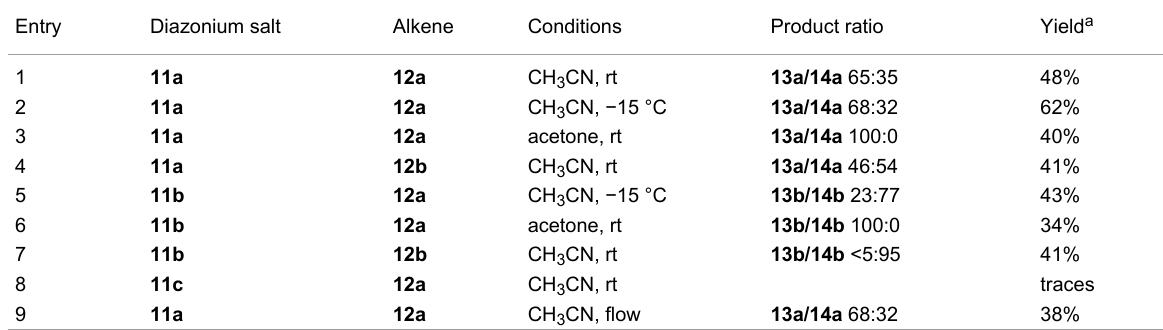
Table 4: Results of the reaction between diazonium salts 11 and alkenes 12 .